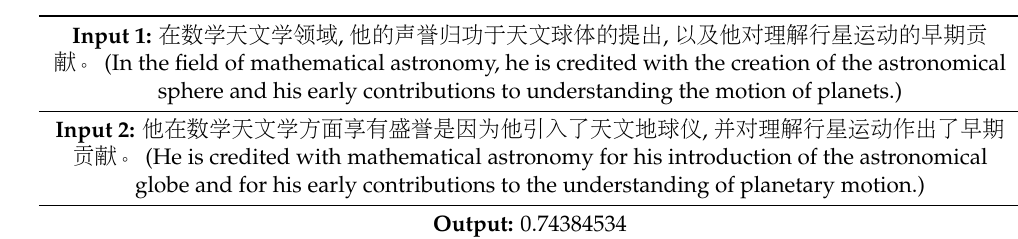
Table 1. Text similarity.